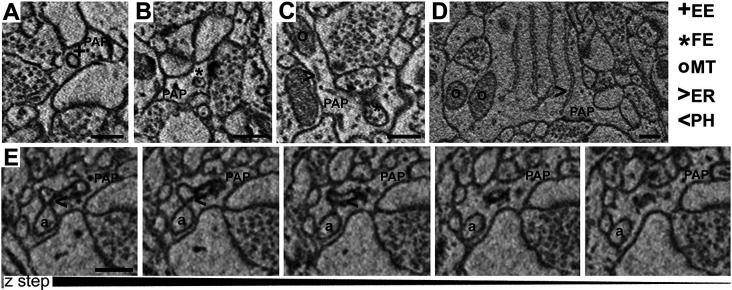
(A–D) Examples of empty endosomes (EE), full endosomes (FE), mitochondria (MT), ER-cisternae (ER). (E) Axon (a) being engulfed by a PAP caught in several consecutive z-steps showing the formation of the phagosome (PH). Scale bar is 300 nm for all panels.